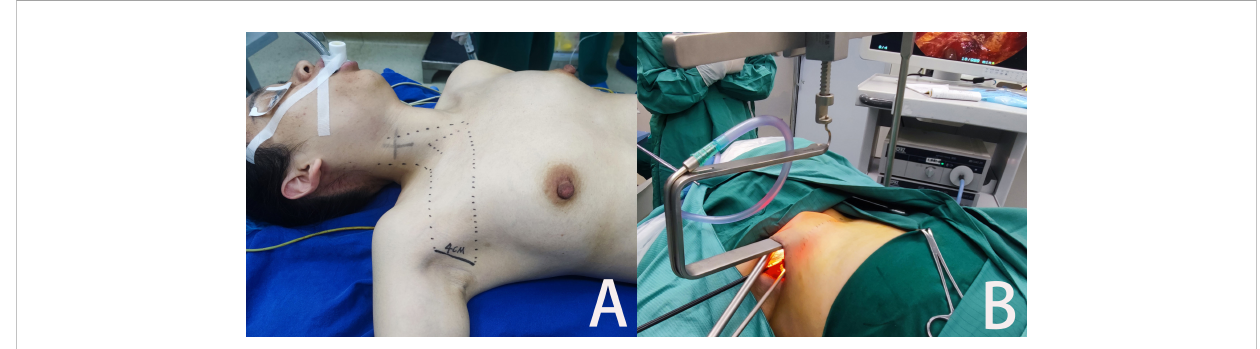
FIGURE 1 Endoscopic thyroidectomy through non-in fl atable axillary approach (A) The patient ’ s position, incision location and the separation area of the anterior chest fl ap. (B) Surgical exterior